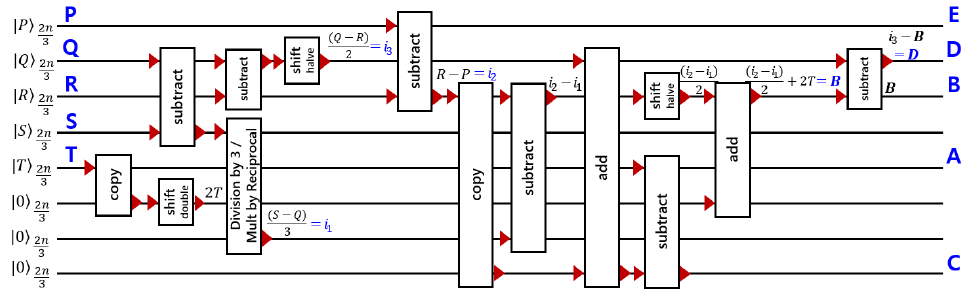
Figure 6. Quantum Circuit for Interpolation